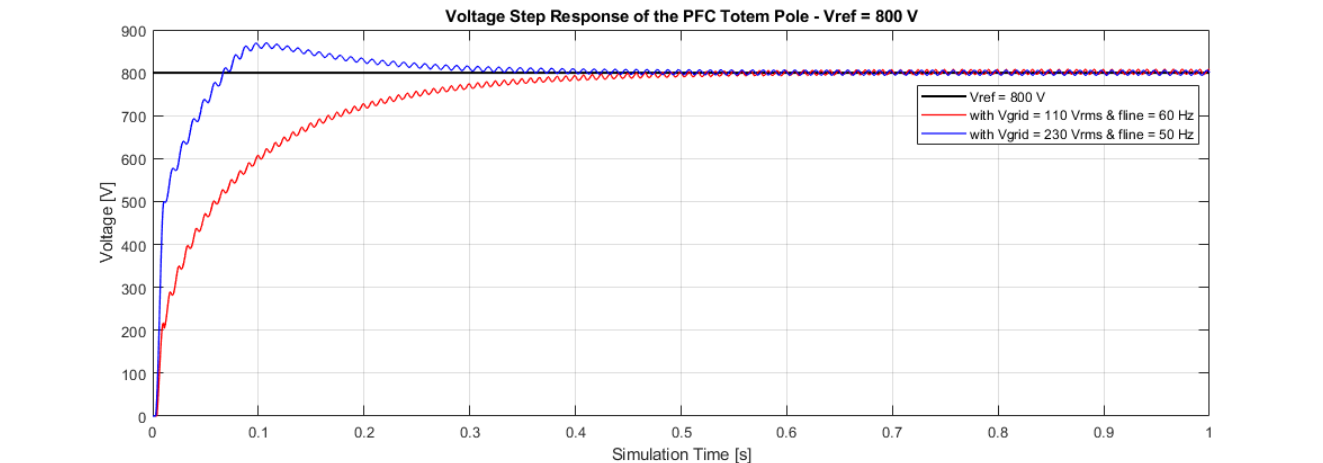
Figure 17. Voltage control of the Totem Pole with V ref = 800